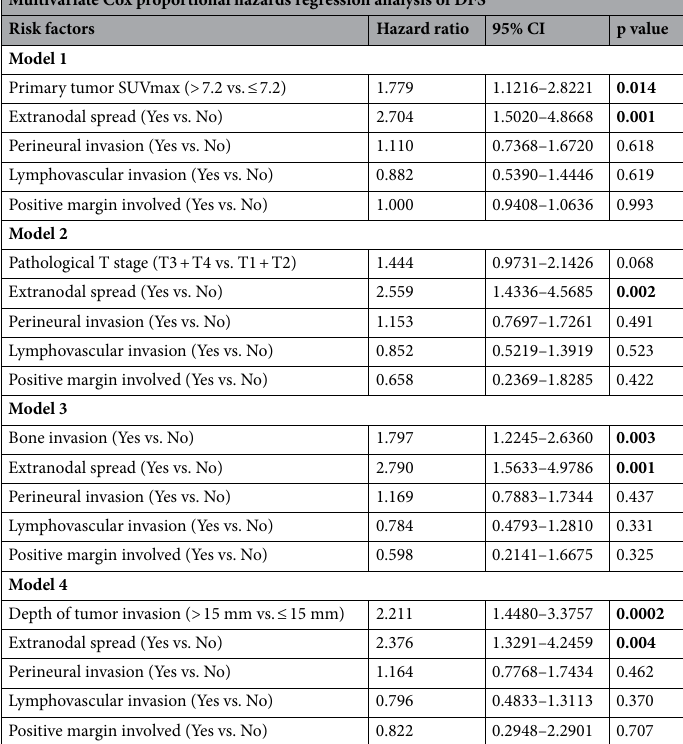
Table 3. Multivariate analysis of different models for DFS. Follow-up period: from date of diagnosis to December 30, 2019.